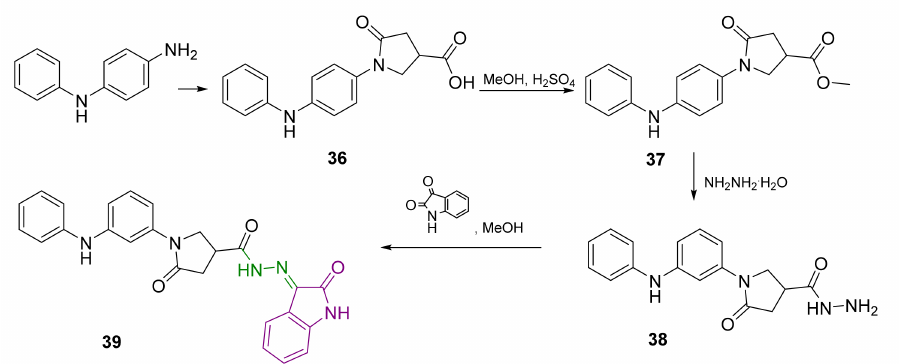
Scheme 4. Synthesis of hydrazone 39 . Azomethine group is marked in green colour and 2-oxindole moiety is represented in purple